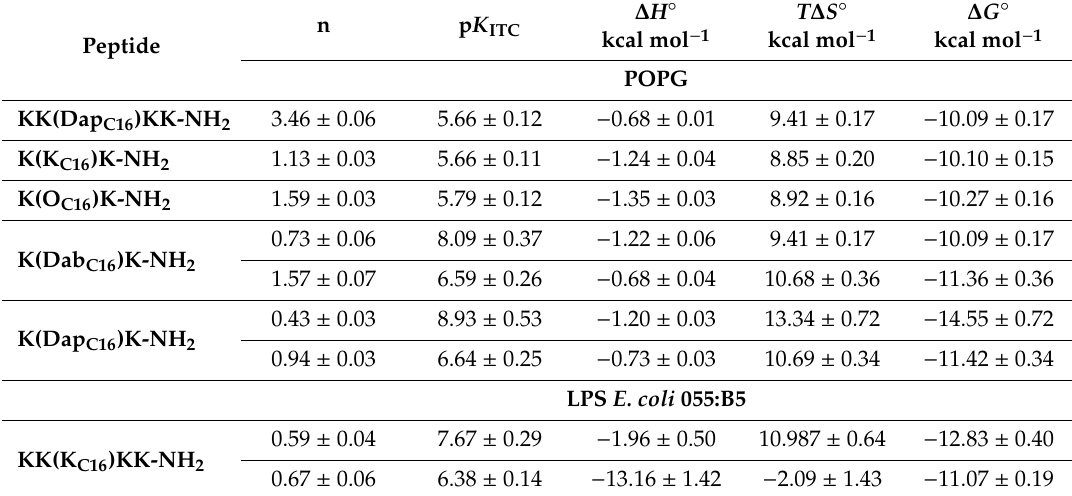
Table 4. Thermodynamic parameters for binding of the lipopeptides to 1-palmitoyl-2-oleoyl- sn - glycero-3-[phospho-rac-(1-glycerol)] (POPG) large unilamellar vesicles (LUVs) and lipopolysaccharide (LPS) E. coli